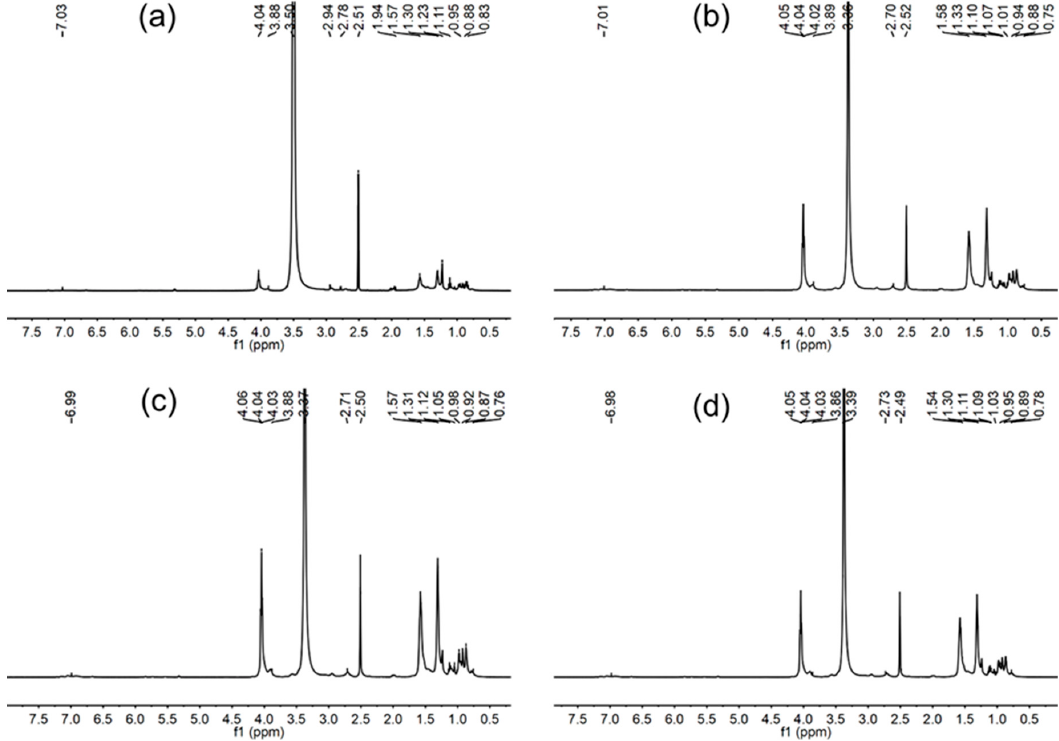
Figure 3. 1 H-NMR spectra of different WPU: ( a ) WPU-0; ( b ) WPU-1; ( c ) WPU-2; and ( d ) WPU-3.